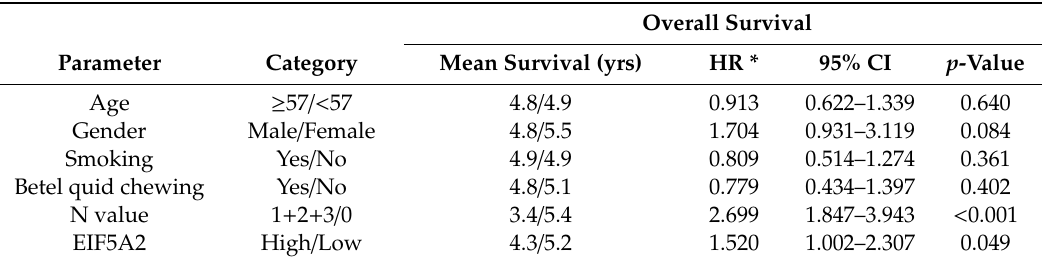
Table 5. Multivariate analysis of the influence of various parameters on the overall survival of oral cancer